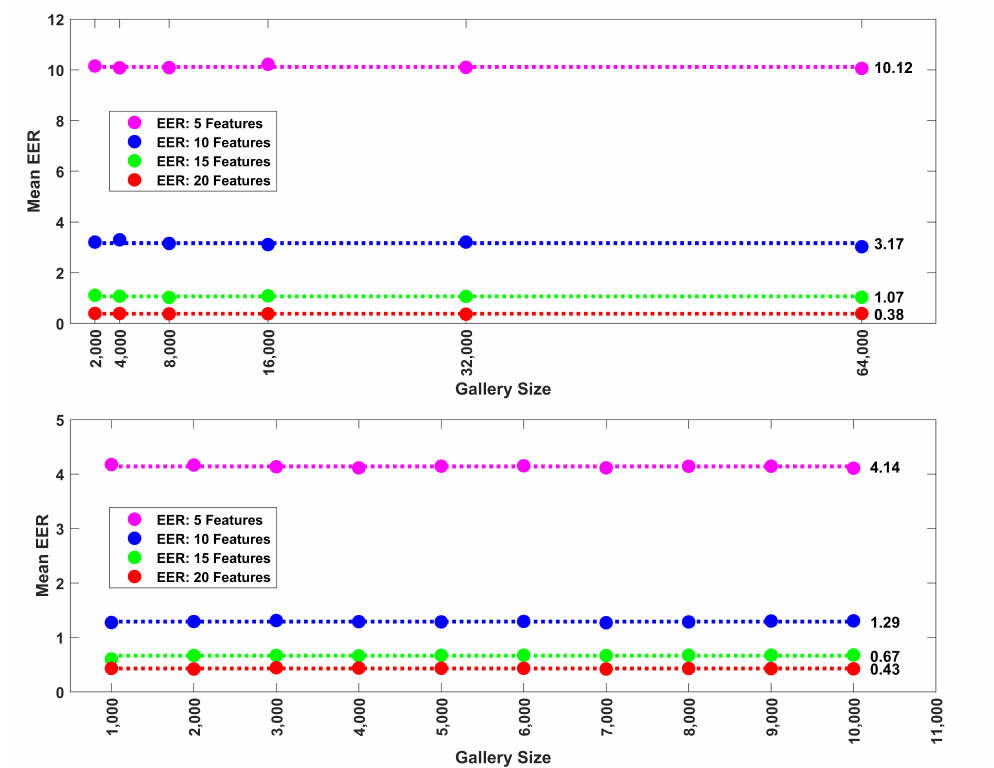
Figure 7. ( Top ): Relationship between mean EER (30 repetitions) and gallery size for synthetic data (Band 8). Data shown for 5, 10, 15 and 20 features. The average EERs (shown to the right of the last dot) across gallery size are illustrated with dotted lines. Mean EER was highly stable with increases in gallery size. ( Bottom ): Relationship between mean EER (30 repetitions) and gallery size (1000 to 10,000 subjects in 1000 subject steps) for FaceNet PCA components. Data shown for the first 5, 10, 15 and 20 PCA components. The average EERs (shown to the right of the last dot) across gallery size are illustrated with dotted lines. Mean EER does not change as a function of gallery